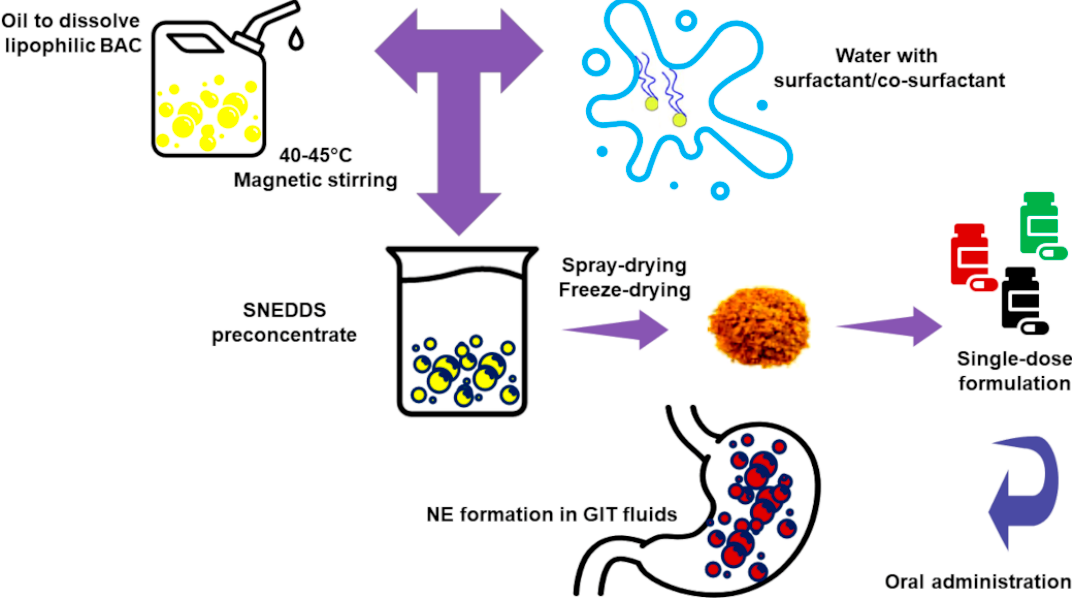
Figure 5. Schematic process for preparing SEEDSs and formation of NE in GIT fluids.